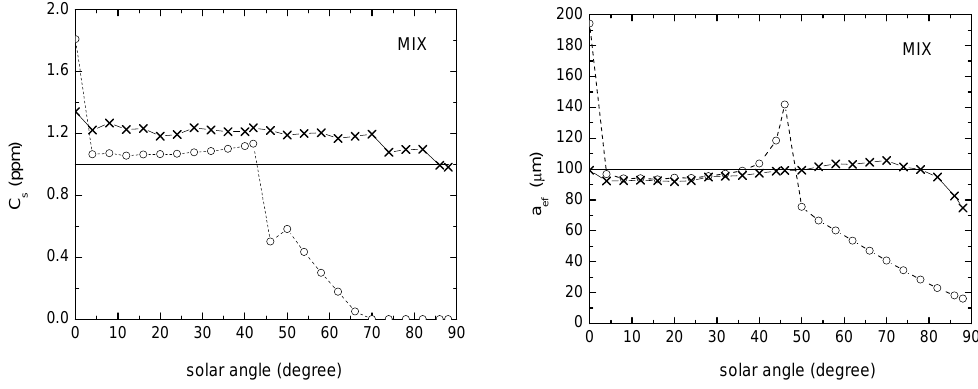
Figure 4. Retrieval of effective snow grain size and soot concentration by two methods: SGSP (-x) and LUT-Mie (-o). Nadir observation. Horizontal lines mark true values.